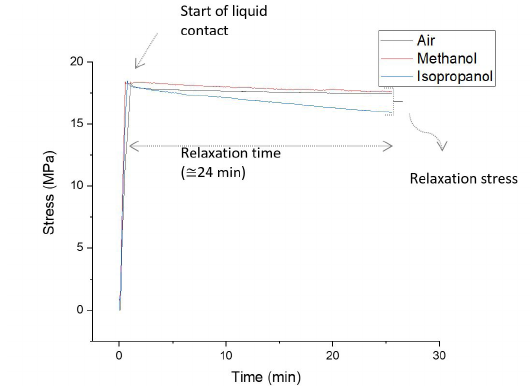
Figure 4. Simple relaxation test curves of non-irradiated PC in three different